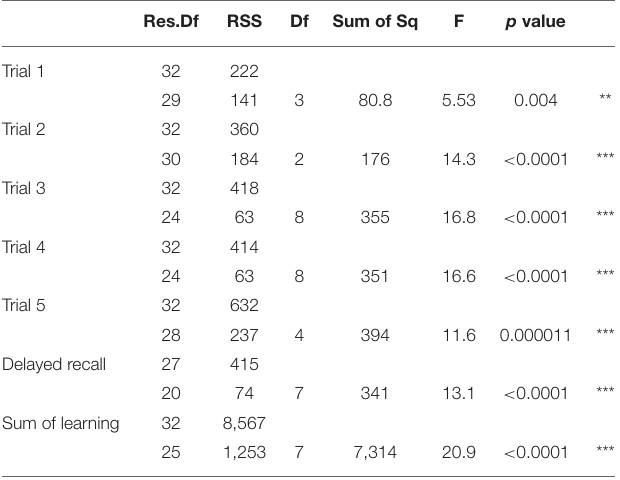
Table 4 ; left STG pole, Table 6 ; mnemonic process (left PHG, Table 4 ; left hippocampus, and Table 5 ; domain-general WM (right MFG, Table 4 ; left MFG, Table 6